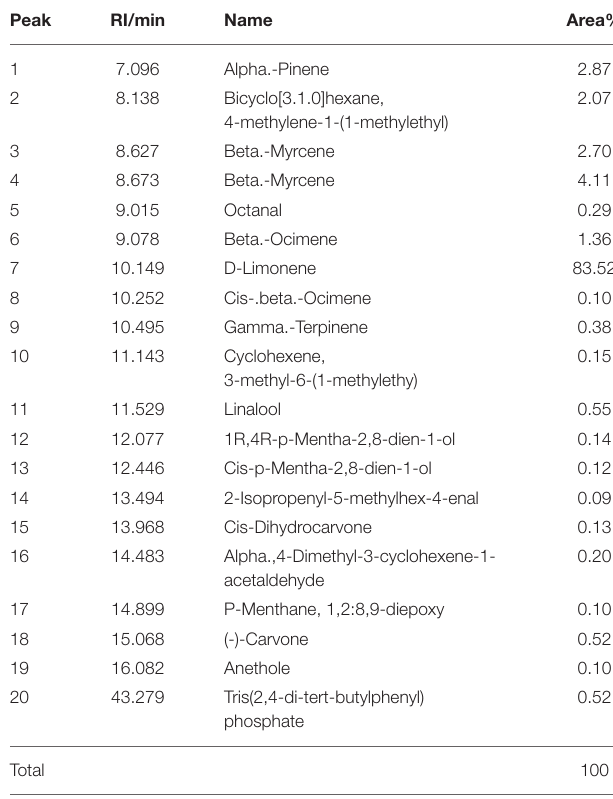
TABLE 1 | Main chemical components and relative contents of LEO. TABLE 2 | Main chemical components and relative contents of DEO. Peak